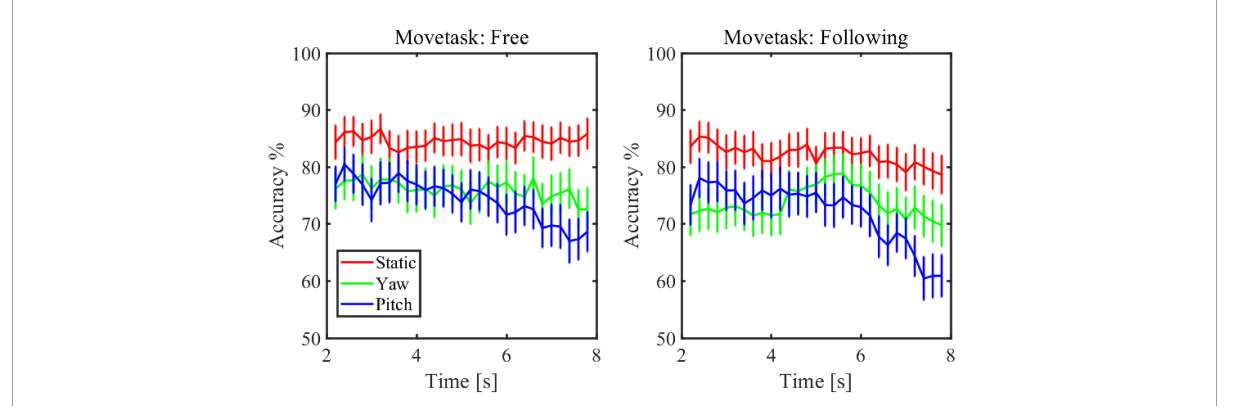
FIGURE9 The change of classification accuracy across different time periods within one